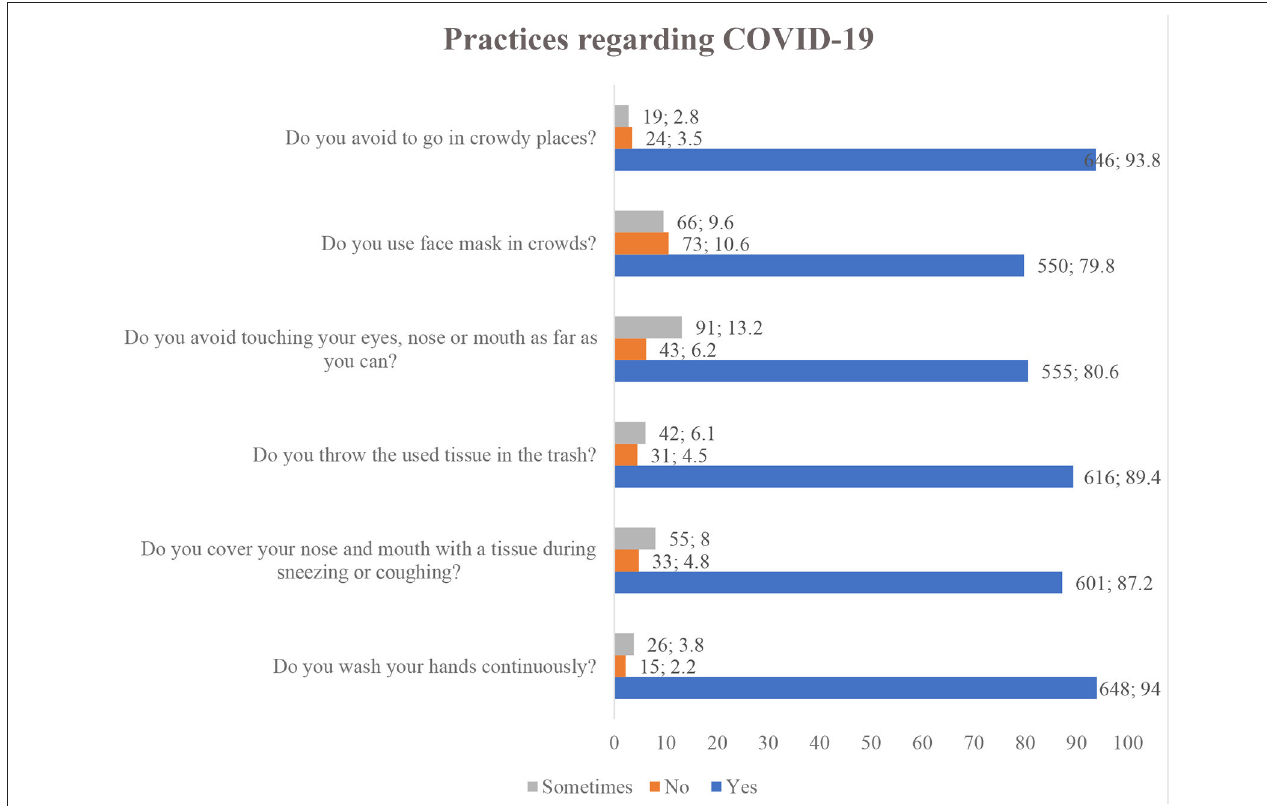
FIGURE 3 | Public practices regarding